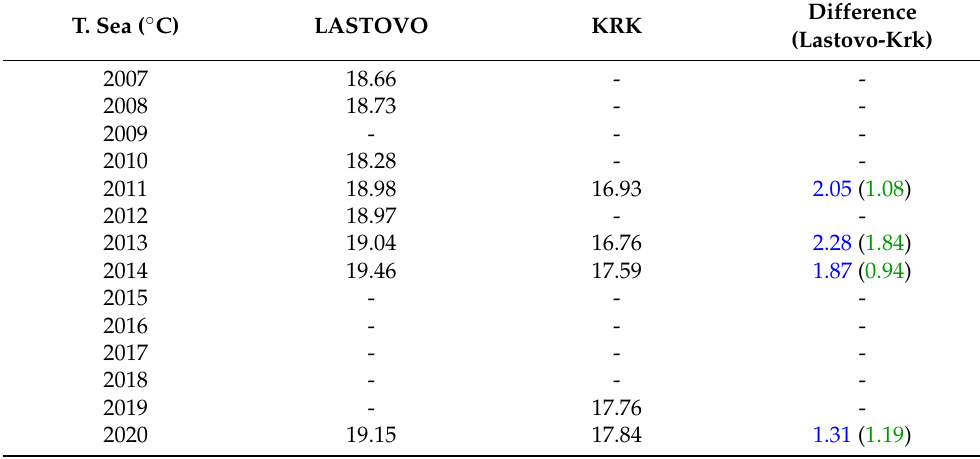
Table 4. The mean annual sea surface temperature of Lastovo and Krk and their differences. T. Sea ( ◦